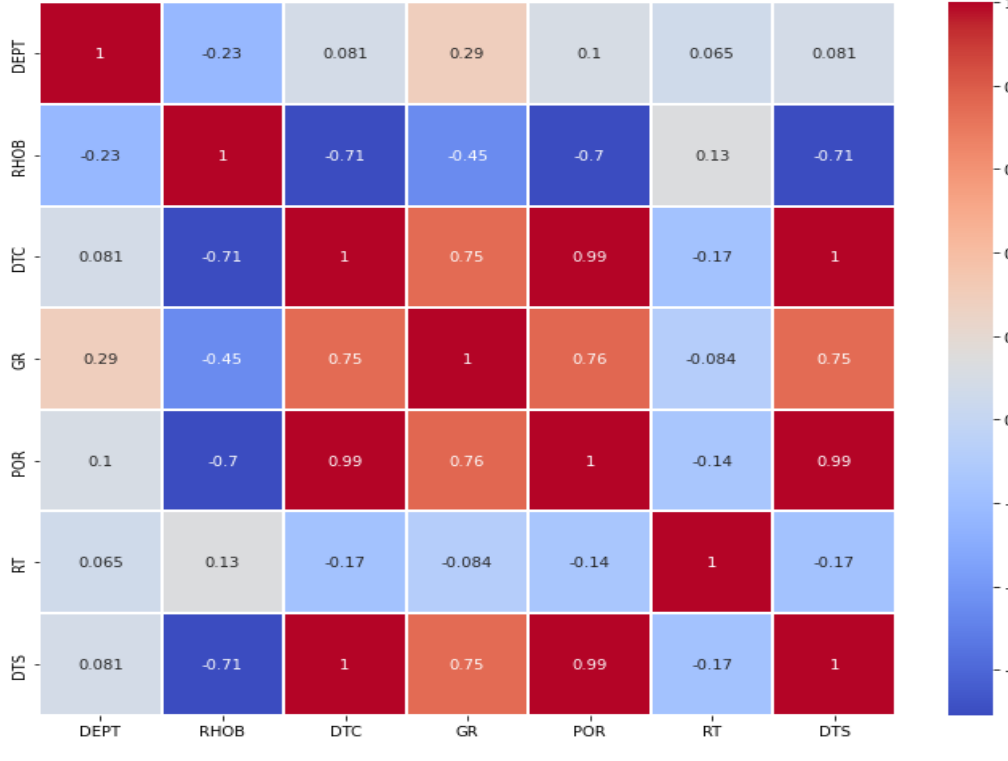
Figure 7. Heat map for a single well.